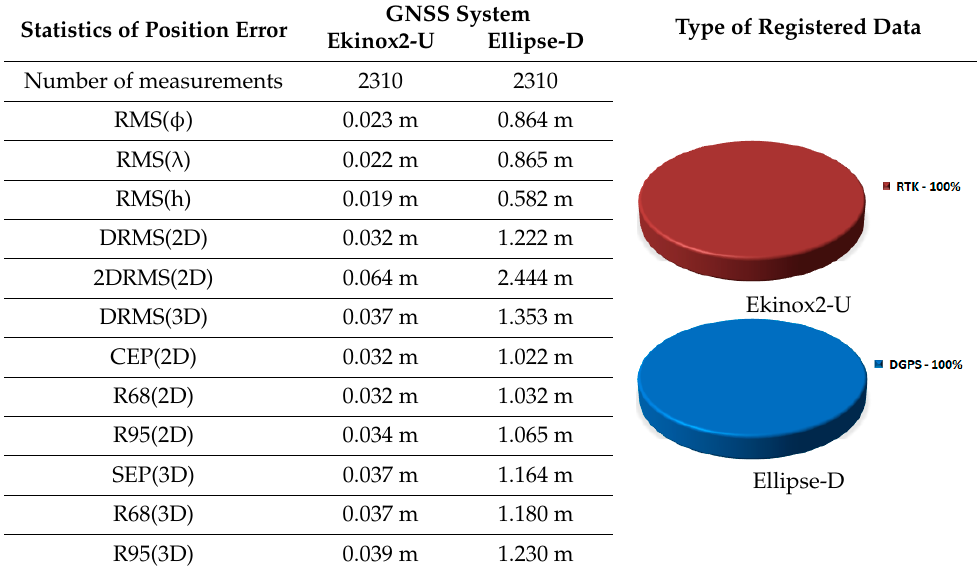
Table 3. The position accuracy measures of the GNSS/INS systems, models Ekinox2-U and Ellipse-D, during the hydrographic surveys on route no. 2.